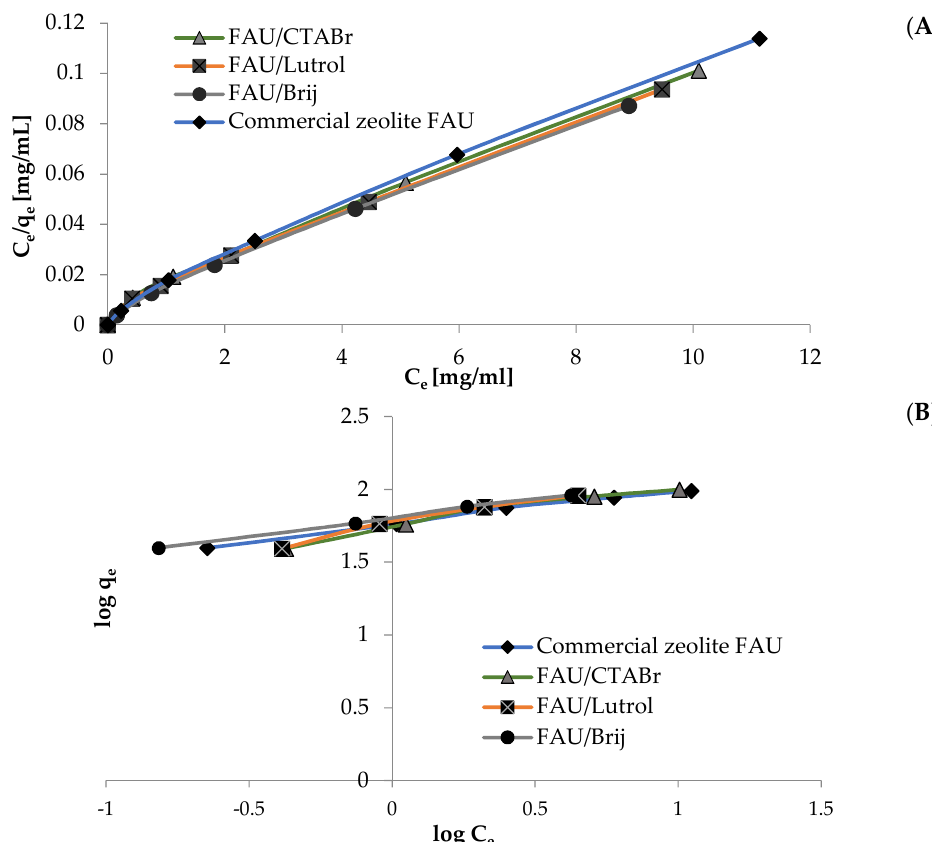
Figure 6. Adsorption of curcumin onto commercial zeolite and hierarchical zeolite: ( A ) Langmuir isotherm plots and ( B ) Freundlich isotherm plots (adsorbent mass = 250 mg, initial solution concen- tration of curcumine = 10–60 mg/mL, volume of solution = 5 mL, temperature = 22 ± 1 °C). Table 4. Curcumin loading into commercial FAU-type